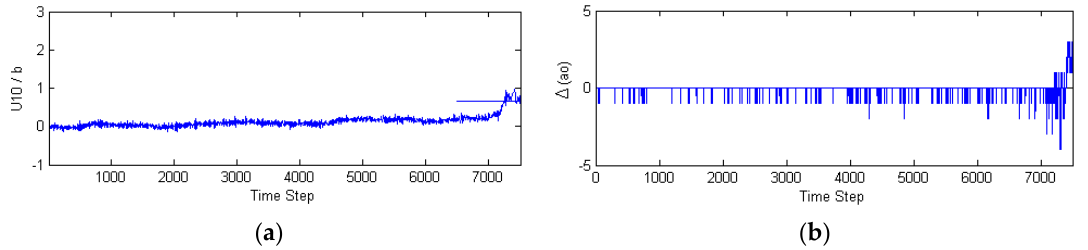
Figure 7. Temperature 300 K, biaxiality ratio α = 1.2: ( a ) the shear displacements U10/ b at the crack tip (layer 15). The short horizontal line to the right denotes the critical value 2/3 needed for easy inclined twinning; ( b ) change of the crack length ∆ ( a o ) (in units of the lattice parameter a o ) in layer 15 . Crack initiation at time step 7223 precedes twinning.